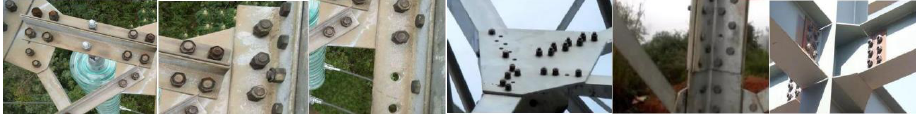
Fig. 2 Sample picture of angle steel tower bolt